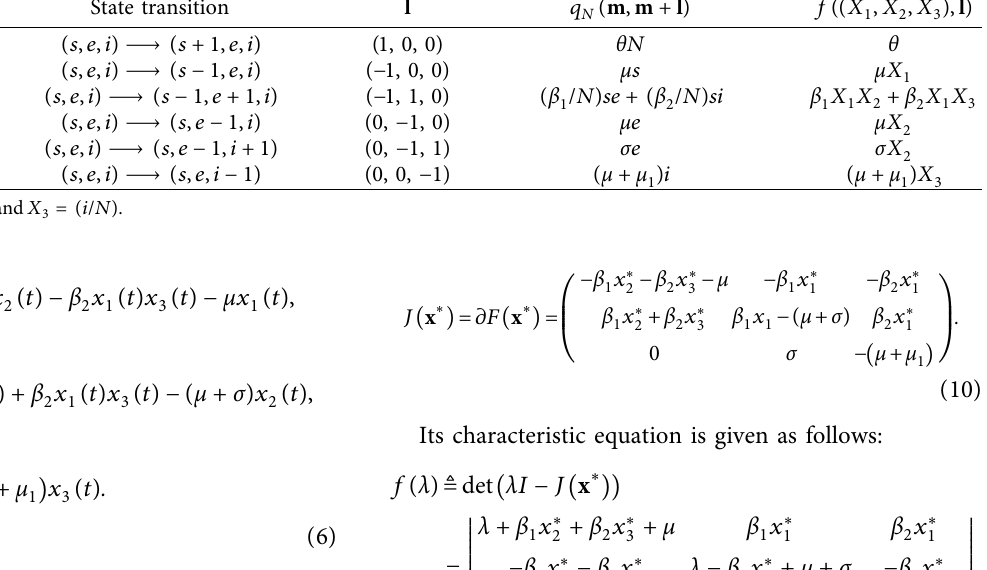
( t ) ,E ( t ) ,I ( t )) : t ≥ 0 􏼈 􏼉 and X N N N